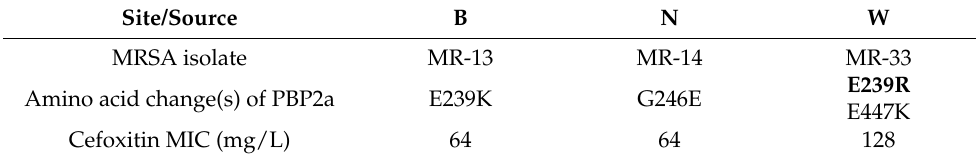
Table 2. The missense mutations of PBP2a associated with the resistance to cefoxitin.